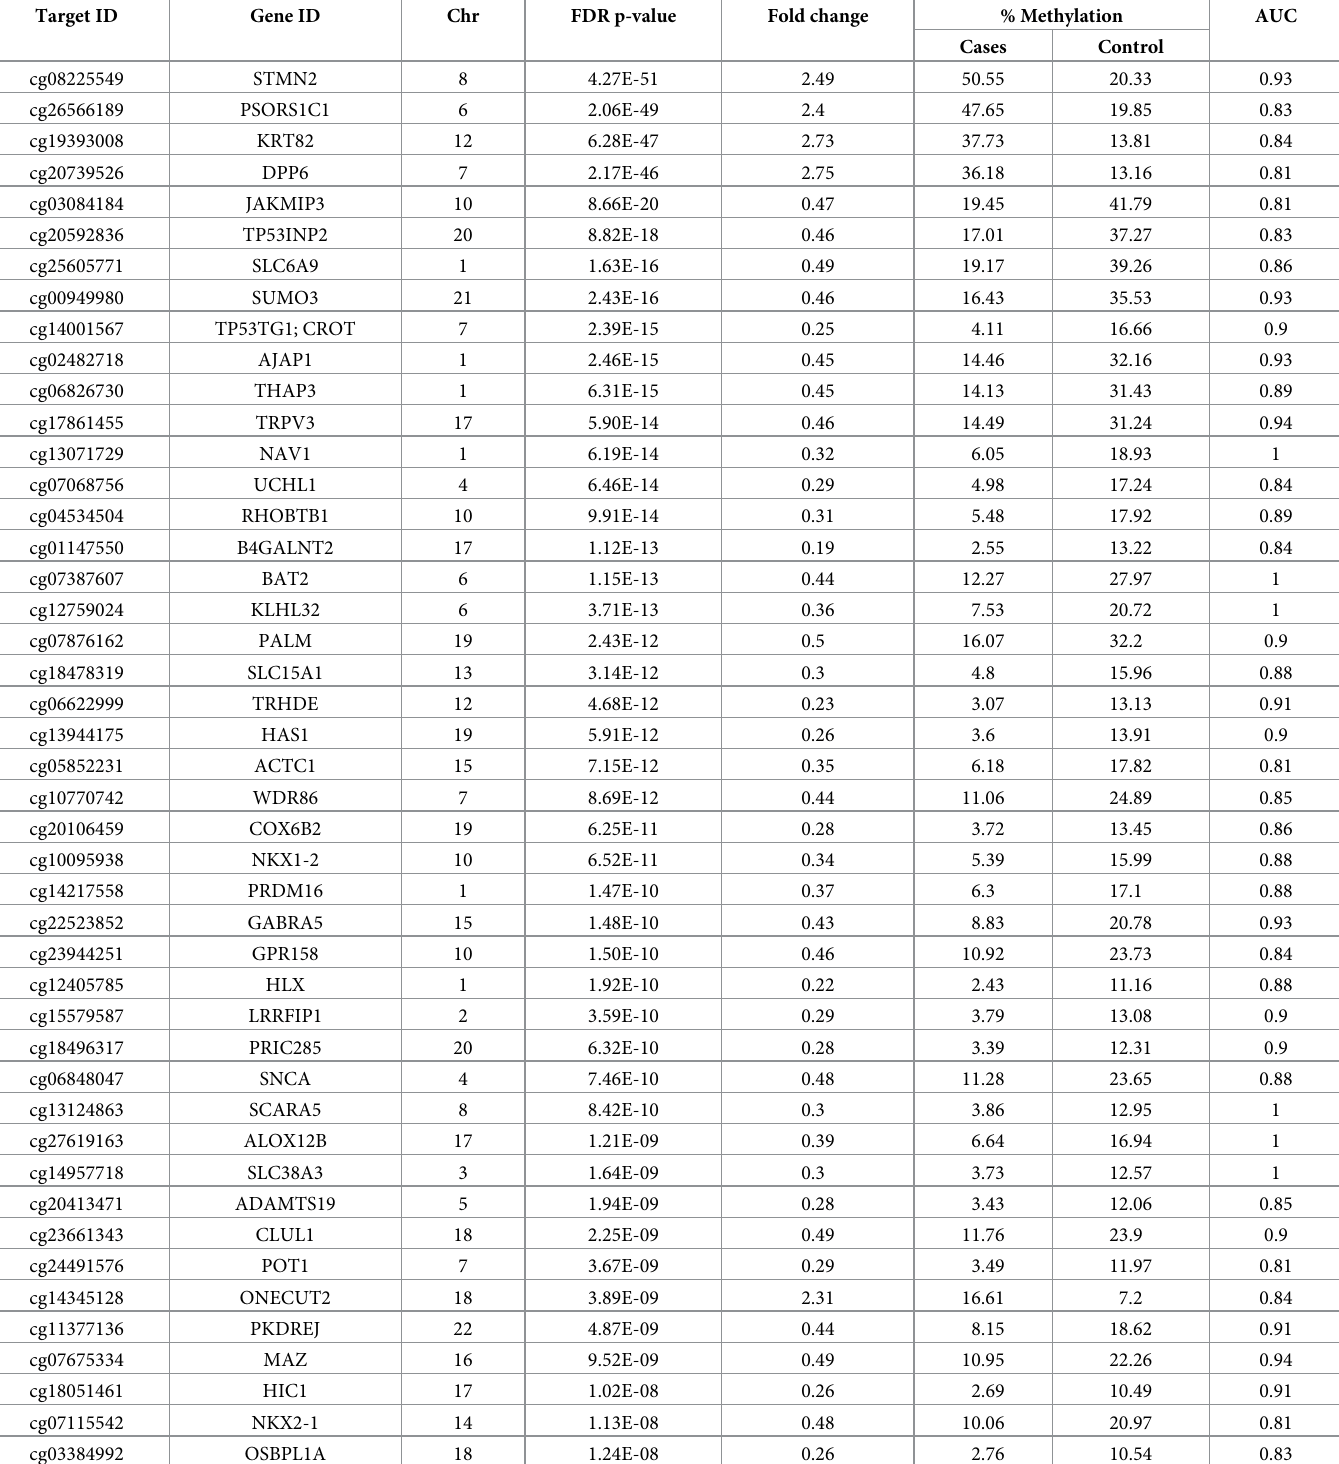
Table 2. Differentially methylated genes with Target ID, Gene ID, chromosome location, FDR p-value, and % methylation change in VSD cases and controls for each target methylated. CpG sites with significant p-value of 5X10 -8 indicating methylation status and area under the receiving operator characteristic curve � 0.80 appear to have strong potential as diagnostic biomarkers for